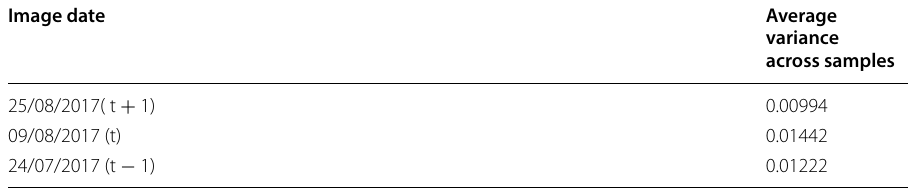
Table 1 Mean NDVI variance across samples and images for crop 1